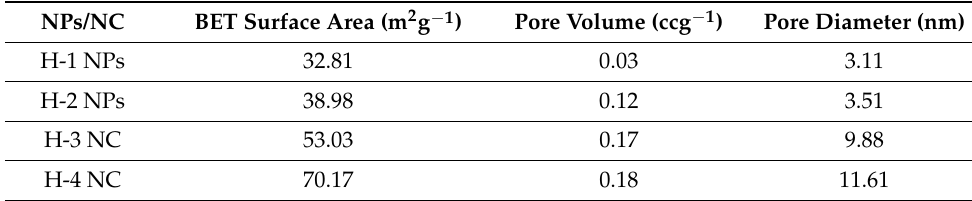
Table 3. BET: The NPs’ specific surface